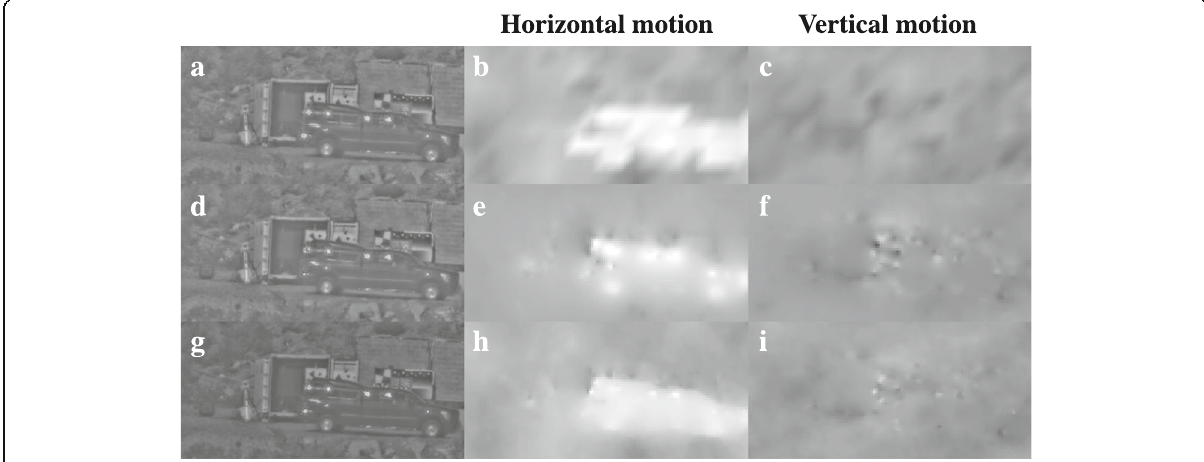
Fig. 6 Comparison of three optical flow methods: Lucas-Kanade ( a – c ), Horn-Schunck ( d – f ), and TV-L1 ( g – i ). The left column shows the turbulence mitigation results for the same frame as Fig. 5, whereas the middle and right column show the estimated motion per pixel for that frame expressed in units of pixels per